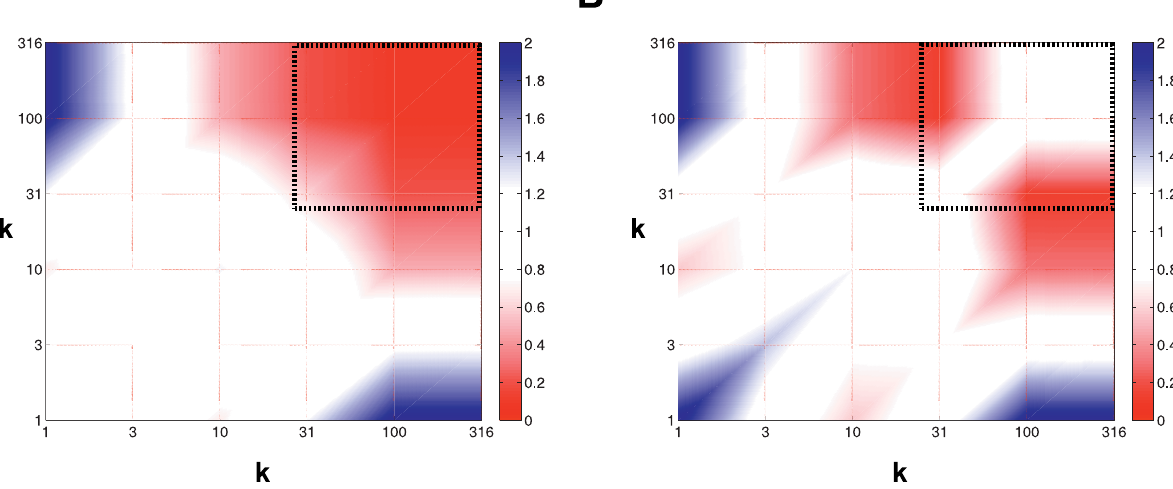
Figure 2. Global Degree Correlation Suggest Bias against Hub–Hub Interactions Proteins in either a combined HTP dataset (A) or the full HC dataset (B) were binned logarithmically by connectivity (with two bins per decade), and interactions among nodes in each of these bins were computed. The ratios of observed over the expected number of interactions are shown; the x - and y -axes both represent connectivity. Degree correlation profiles were computed as described in the Methods section; expected values were computed by generating 50 random networks generated via edge-swapping procedure as described [16]. All colored regions are statistically significant (standard deviation greater than or equal to 6 3, representing p , 0.01), with enrichment highlighted in blue and depletion in red; ratios colored in white do not deviate significantly from unity. Areas bounded by rectangles represent interaction space between hubs, defined as the degree threshold exceeded by 10% of the hubs. This threshold was 18 for HTP and 21 for HC. DOI: 10.1371/journal.pbio.0040317.g002